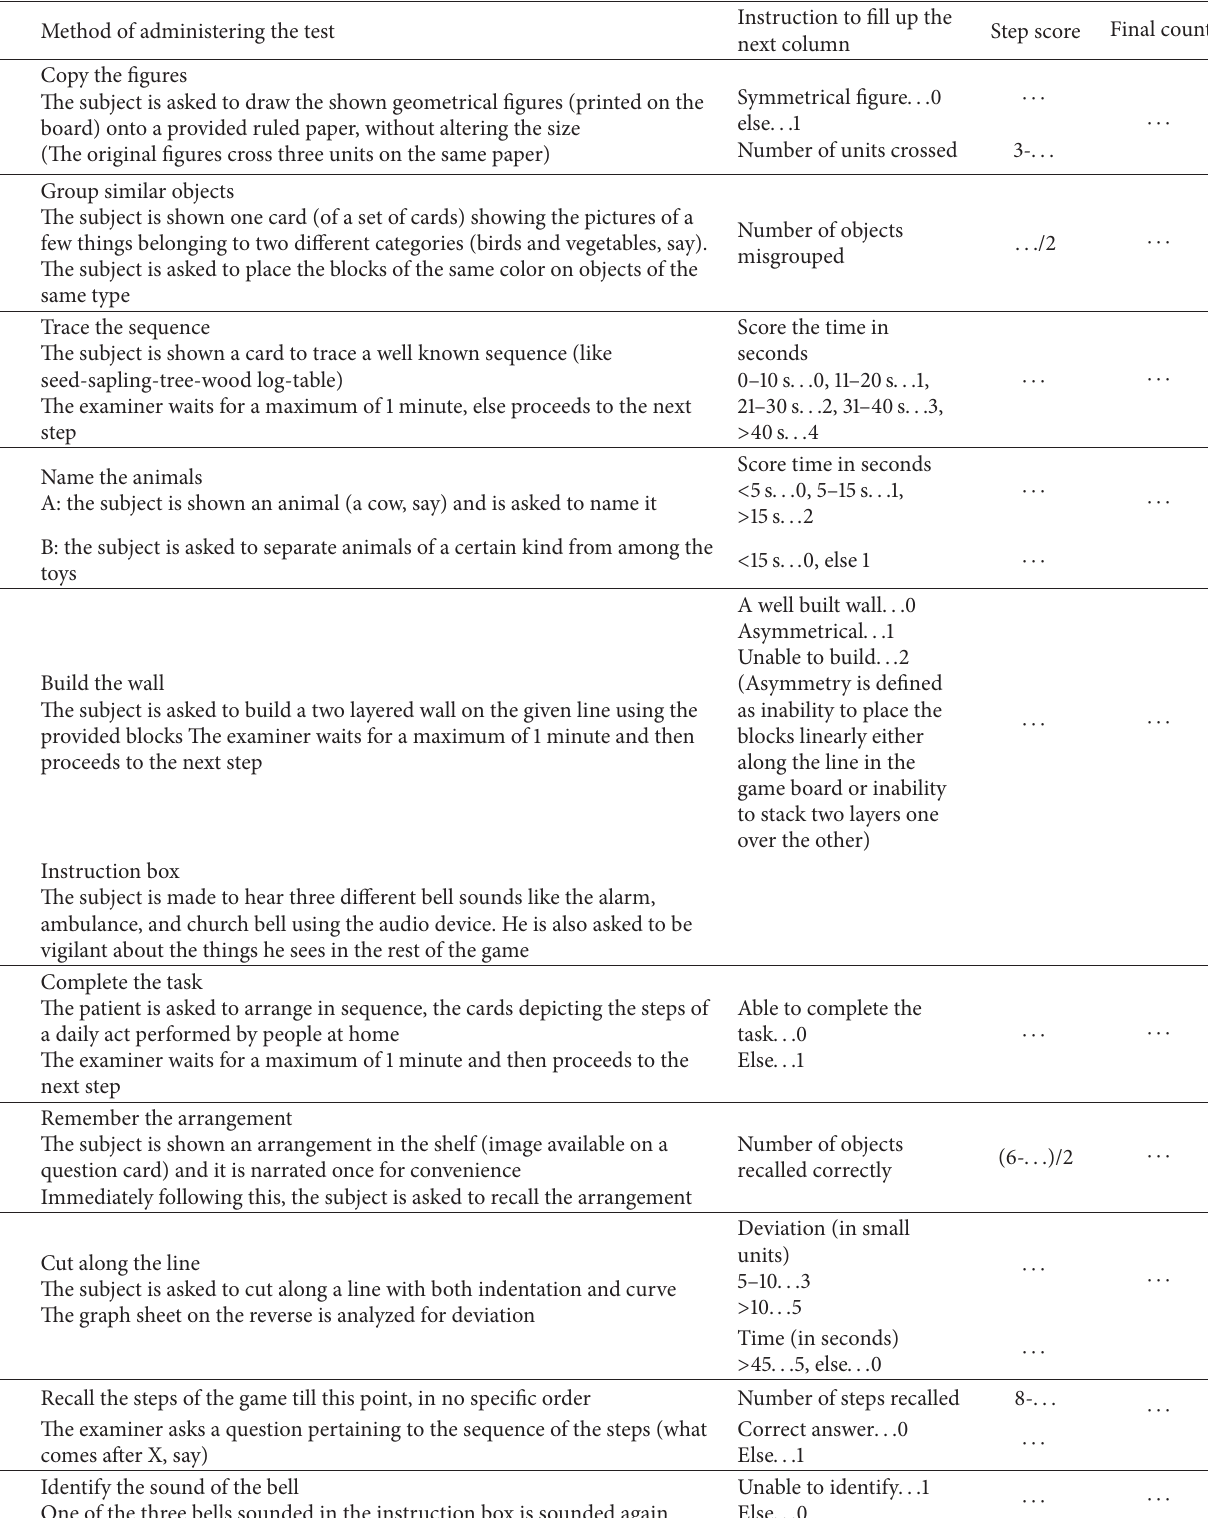
Table 2: MALT instruction cum scoring